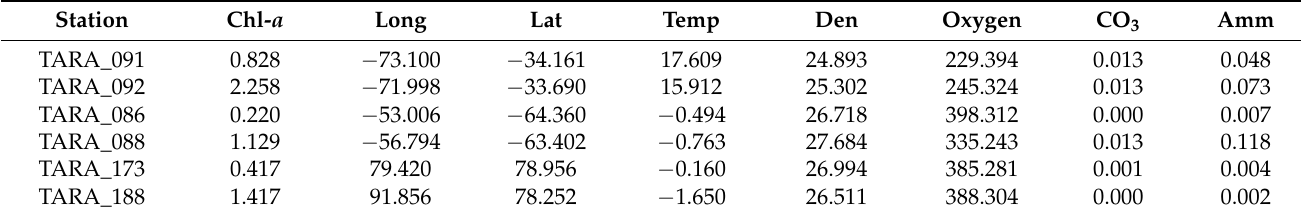
Table 1. Samples with outlier Chl- a values and samples adjacent to them.